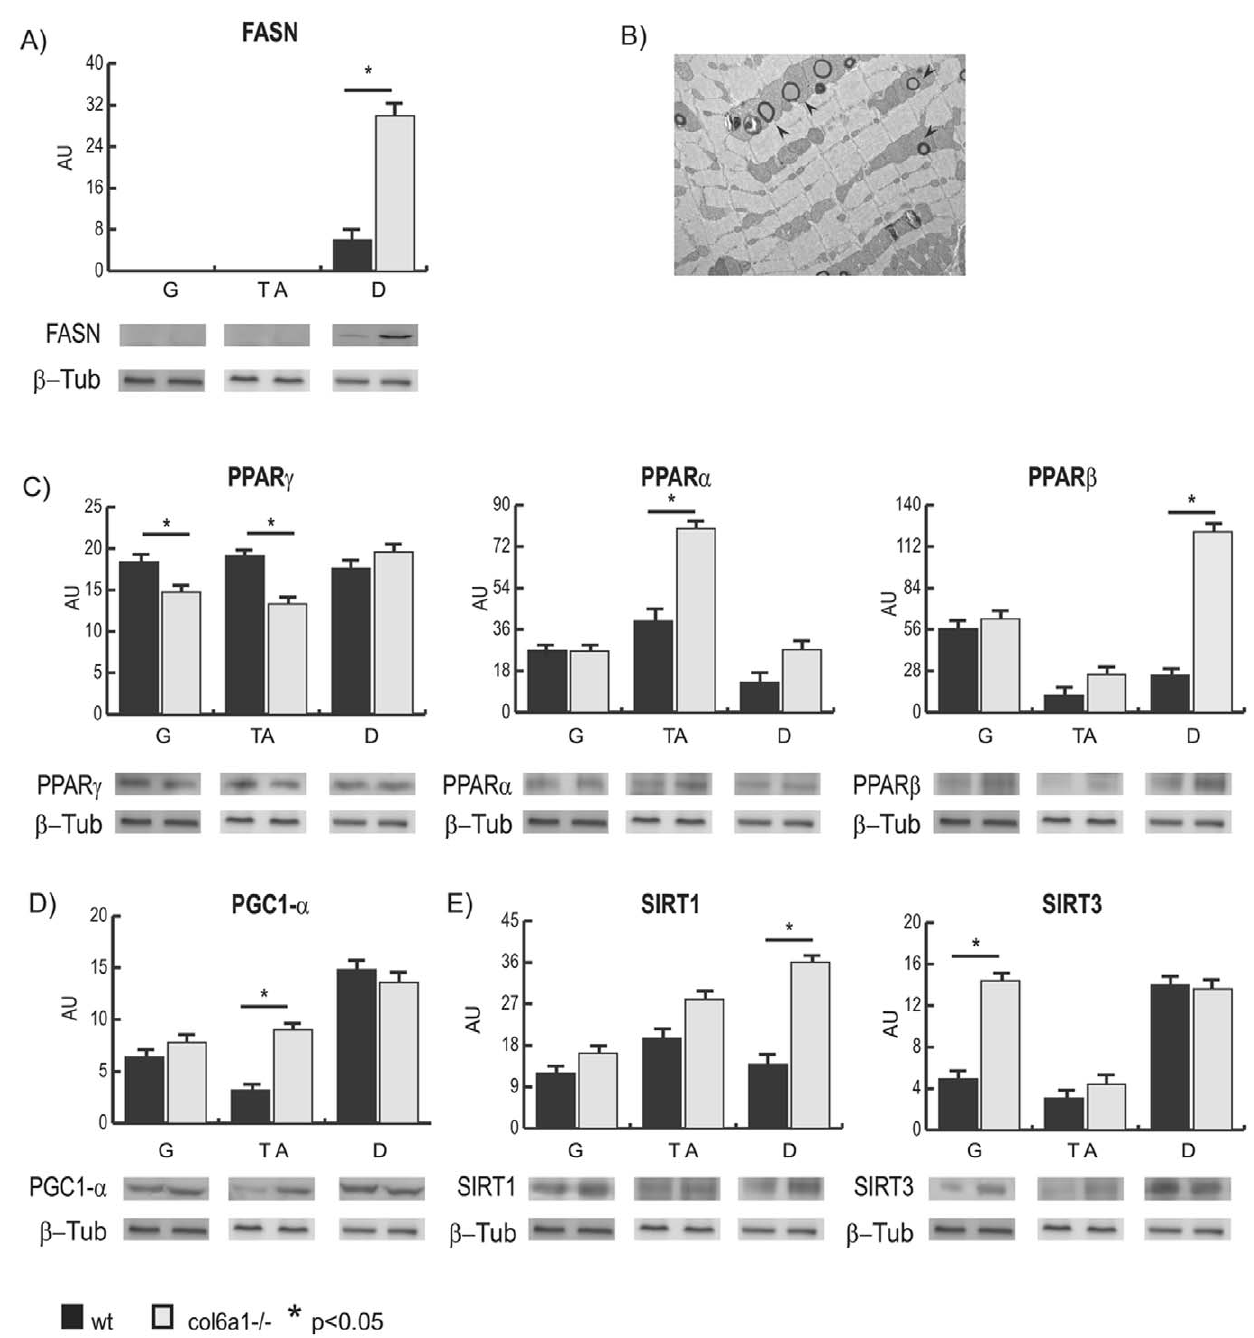
Figure 5. Immunoblotting of proteins involved in lipid metabolism. Histograms and representative immunoblot images of FASN (panel A), PPAR c , a and b (panel C), PGC1- a (panel D), SIRT1 and SIRT3 (panel E) in gastrocnemius, tibialis anterior and diaphragm from Col6a1 2 / 2 and wild-type mice (n=4; mean 6 S.D.; Student’s T-test). Panel B: electron microscopy image showing lipid accumulation in the diaphragm of Col6a1 2 / 2 mice. Black arrows show lipid droplets. doi:10.1371/journal.pone.0056716.g005 contractile proteins were decreased (actin capping protein A, Capzb; tropomyosin 1 alpha and beta chains, Tpm1 and Tpm2; 14-3-3 protein gamma, Ywhag; troponinin I fast, Tnni2; myosin A1 catalytic light chain, Myl1; myosin light chain phosphoryla- table fast isoforms, Mylpf), suggesting instability of actin filament, muscle fiber damage, force development impairment, deregulation